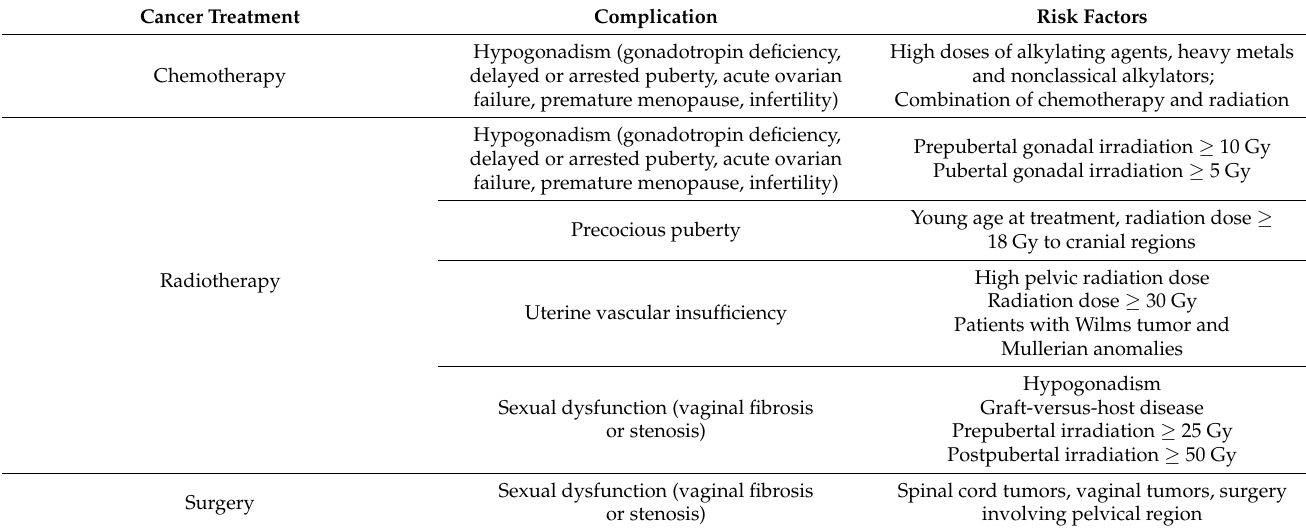
Table 4. Female reproductive complications associated with cancer treatment [102,103]. Cancer